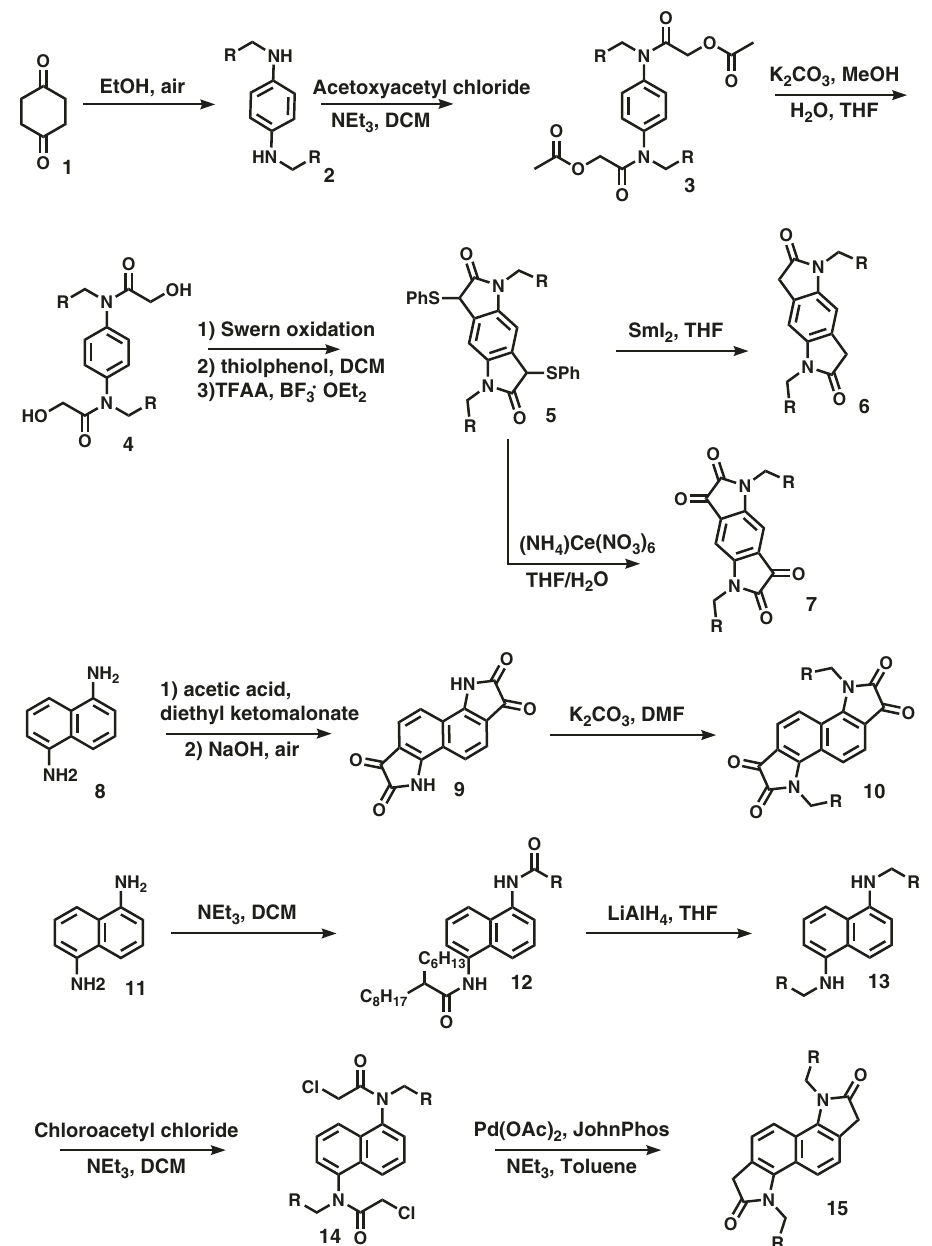
Fig. 2 Synthesis of phenyl bis-isatin, phenyl bis-oxindole, naphthalene bis-oxindole and naphthalene bis-isatin monomers. The letter R represents different solubilising alkyl chains used in the synthesis of each monomer as outlined in Supplementary